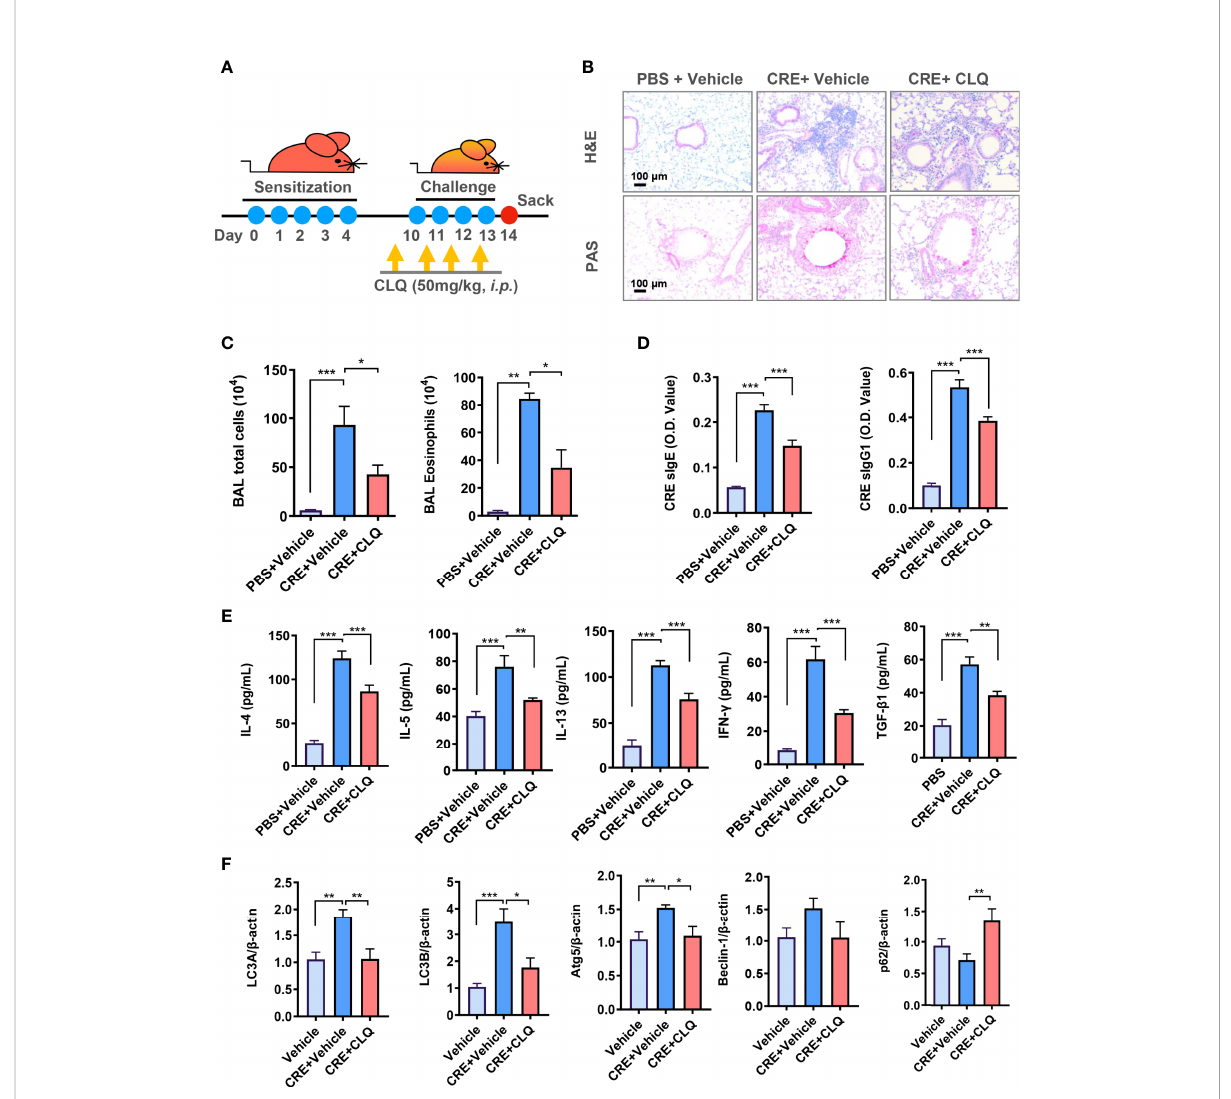
FIGURE 5 Inhibition of autophagy attenuates allergic airway in fl ammation. (A) Experimental scheme for cockroach allergen – induced mouse model of asthma in the presence or absence of autophagy inhibitor chloroquine (CLQ). (B) Histological examination of mouse paraf fi n lung sections stained with hematoxylin and eosin (H&E, upper panel) and periodic acid – Schiff (PAS, lower panel). (C) Bronchoalveolar lavage (BAL) fl uid total and eosinophil cell counts as assessed by fl ow cytometry. (D) Serum levels of cockroach allergen – speci fi c IgE and IgG1. (E) Levels of cytokines in BALFs. (F) RT-PCR analyses of autophagy-related genes in the lung tissues of asthma mouse model. n = 10. Data represent means ± SEM. * p < 0.05, ** p < 0.01, and *** p <